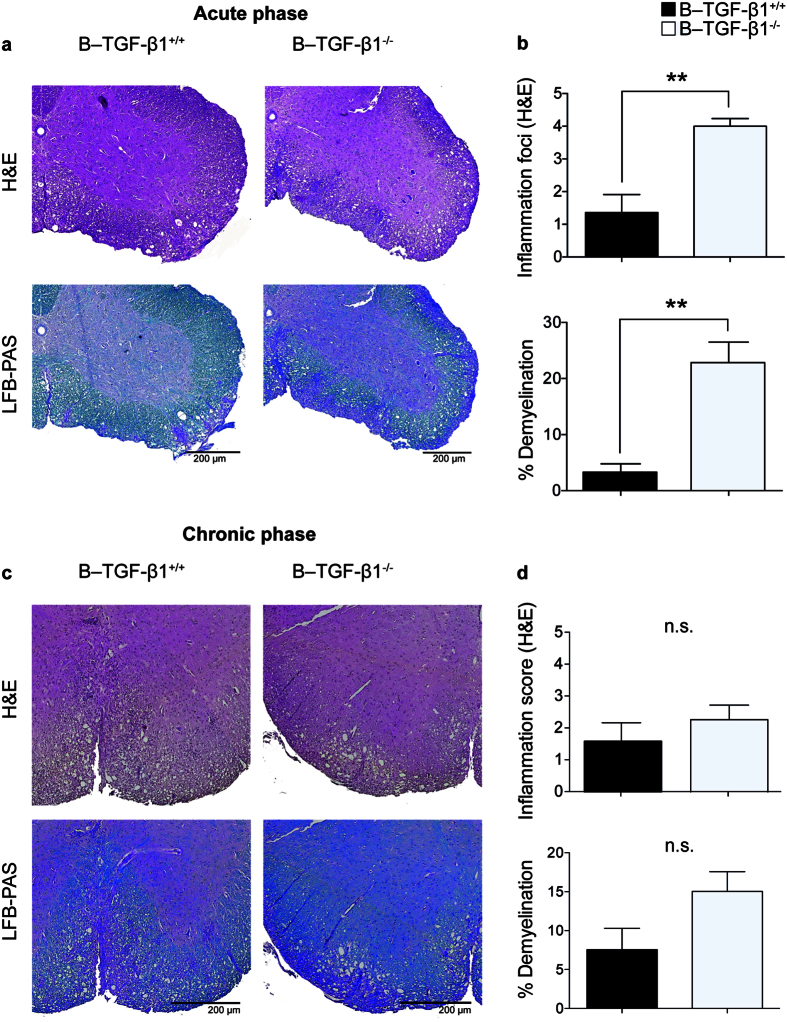
EAE acceleration in B–TGF-β1−/− mice is associated with augmented spinal cord inflammation and demyelination.Mice selected for histologic examination had clinical scores at the time of sacrifice that represented the mean for their group. (a) Representative images of paraffin-embedded spinal cord sections from indicated groups sacrificed on day 14 stained for H&E or Luxol Fast Blue/PAS stain (LFB-PAS) are shown. The average number of inflammatory lesions (b, top) and extent of demyelination (b, bottom) is shown. (c) Representative images of spinal cord sections from indicated groups sacrificed on day 25 stained for H&E or LFB-PAS are shown. The average number of inflammatory lesions (d, top) and extent of demyelination (d, bottom) is shown. Bar = 200 μM, 5–8 sections of spinal cord per mouse (n = 5 per group) are presented as bar graphs, mean ± SEM. **P <  0.01 by Student’s t-test.